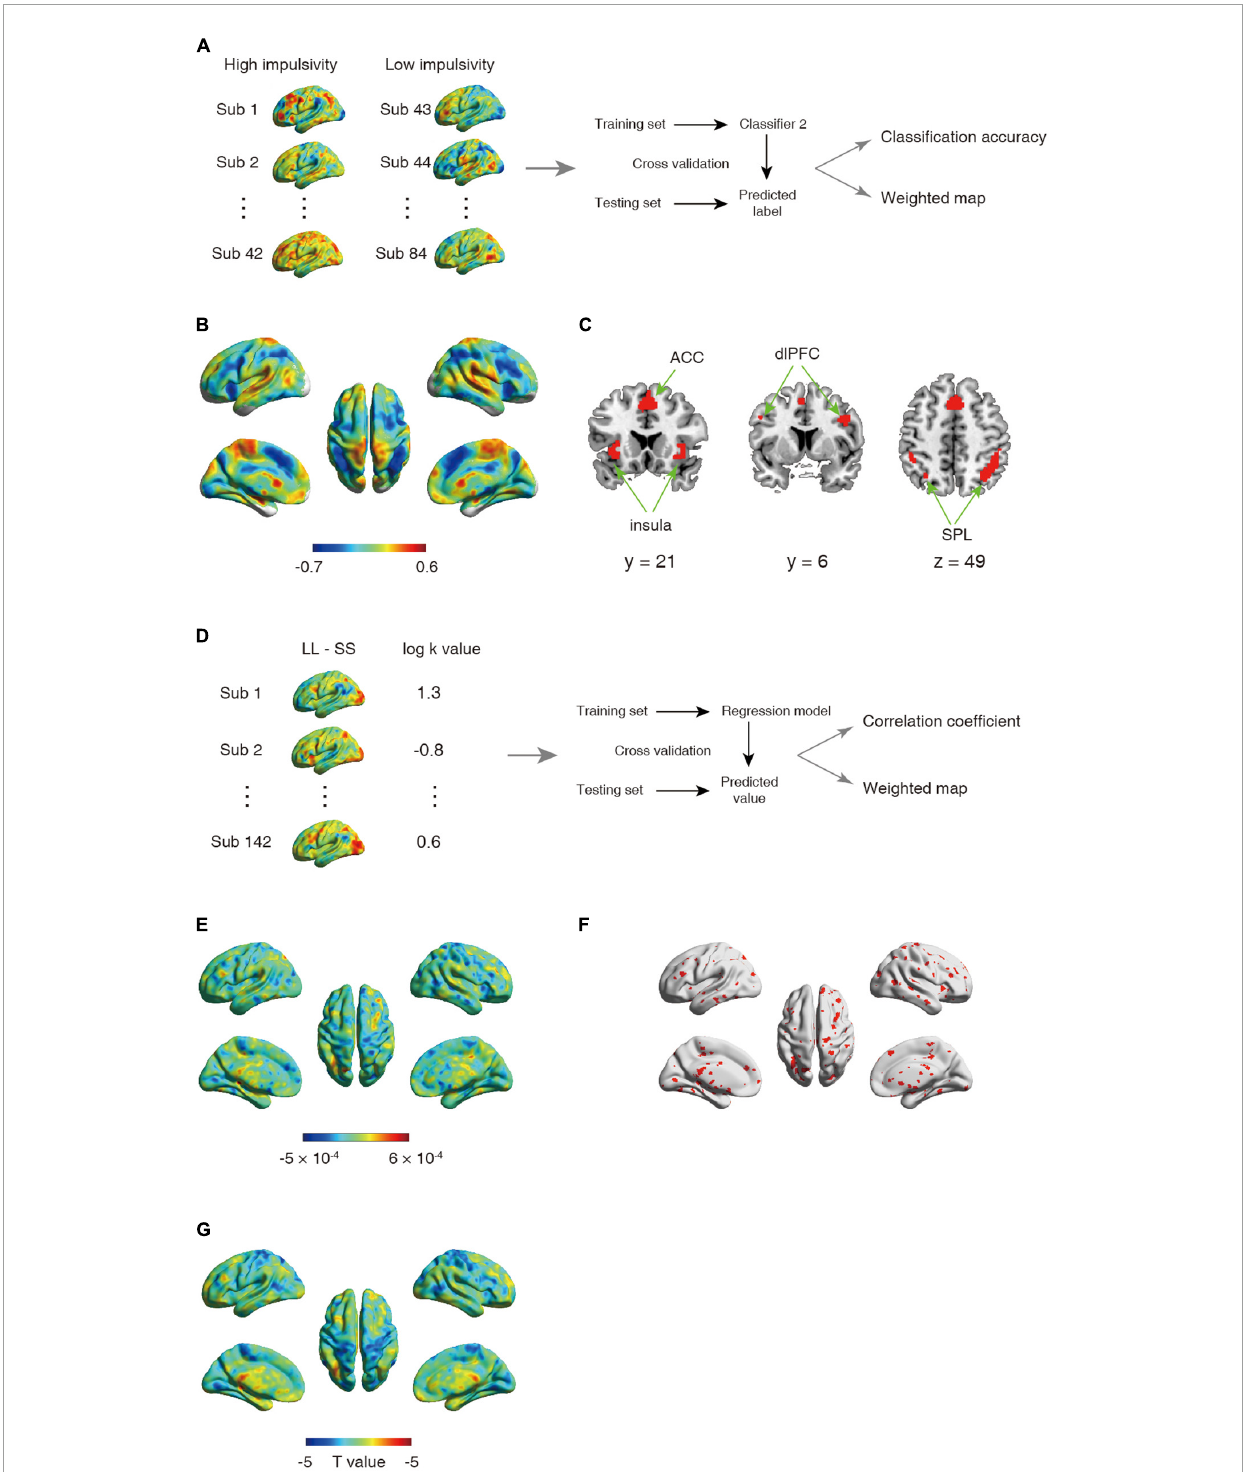
FIGURE2 (A–C) Schematic overview of analysis for second classifier and corresponding results. (A) The univariate analysis was first used to obtain the activation map for contrast between larger later choice and small sooner at the individual level. The whole-brain activated parametric values from the univariate activation map for high ( n = 42) and low ( n = 42) impulsive participant were extracted as the features, which were then used to build classifier. (B) The whole-brain weighted map. The color bar indicates weight value. (C) The top 1% voxel with highest weights (absolute value). Specially, all these voxels were with negative weights. (D–F) Schematic overview of a support vector regression (SVR) analysis and the corresponding results. (D) The univariate analysis was first used to obtain the activation map for contrast between larger later choice and small sooner at the individual level. The whole-brain activated parametric values from the univariate activation map for all participant ( n = 142) were extracted as the features, which were then used to build classifier. (E) The whole-brain weighted map. The color bar indicates weight value. (F) The top 5% voxel with highest weights (absolute value). (G) Statistical t-map for correlation between one’s log k-value and brain